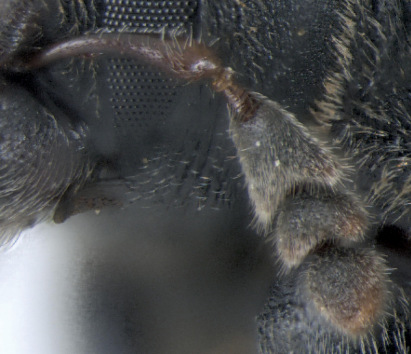
Aricerus sp. antenna.